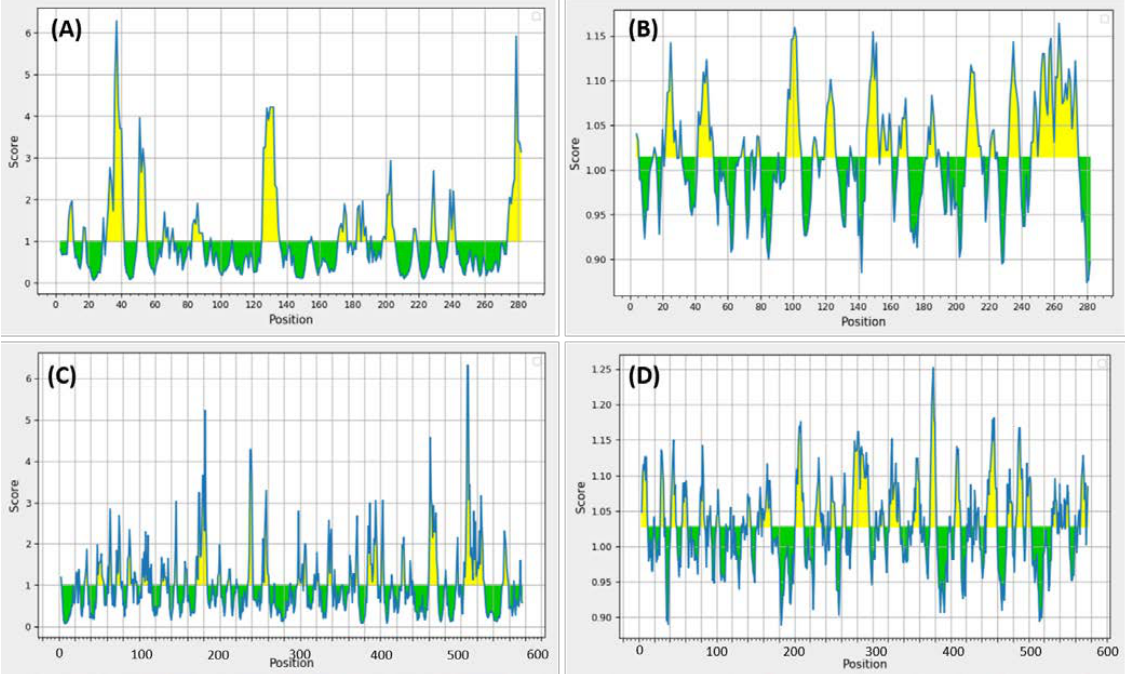
Figure 1. ( A ) Antigenicity scores of phytoene dehydrogenase residues. ( B ) Antigenicity scores of the hypothetical protein residues. ( C ) Surface accessibility scores for the residues of phytoene dehydrogenase. ( D ) Surface accessibility scores for the residues of the hypothetical protein.